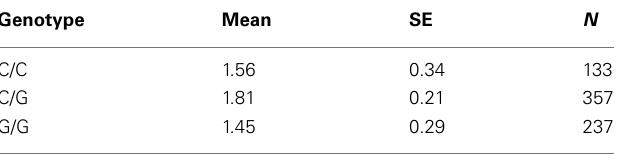
Table 7D |Adjusted mean percent weight gain corresponding to genotypes at rs9922047 ( FTO ), using model 2.